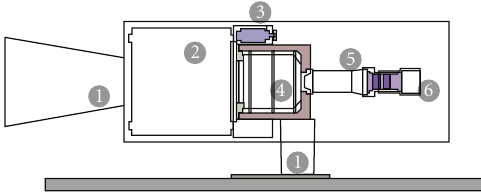
Figure 1: Schematic view of a TORTORA design. (1) Protective blend, (2) main objective, (3) main objective focusing unit, (4) image intensifier, (5) transmission optics and CCD focusing unit, and (6) fast CCD.